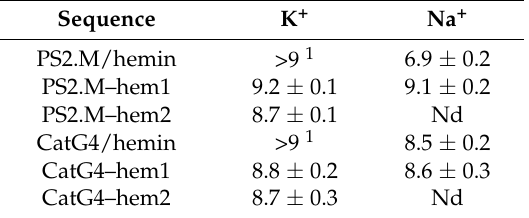
Figure 3. Catalytic activity of various enzymatic systems in an oxidation reaction of 2,2′-azino-bis(3- ethylbenzothiazoline-6-sulphonic acid) (ABTS) with hydrogen peroxide. The colors of the bars represent the reactions in the presence of potassium cations (brown) and sodium cations (orange), or